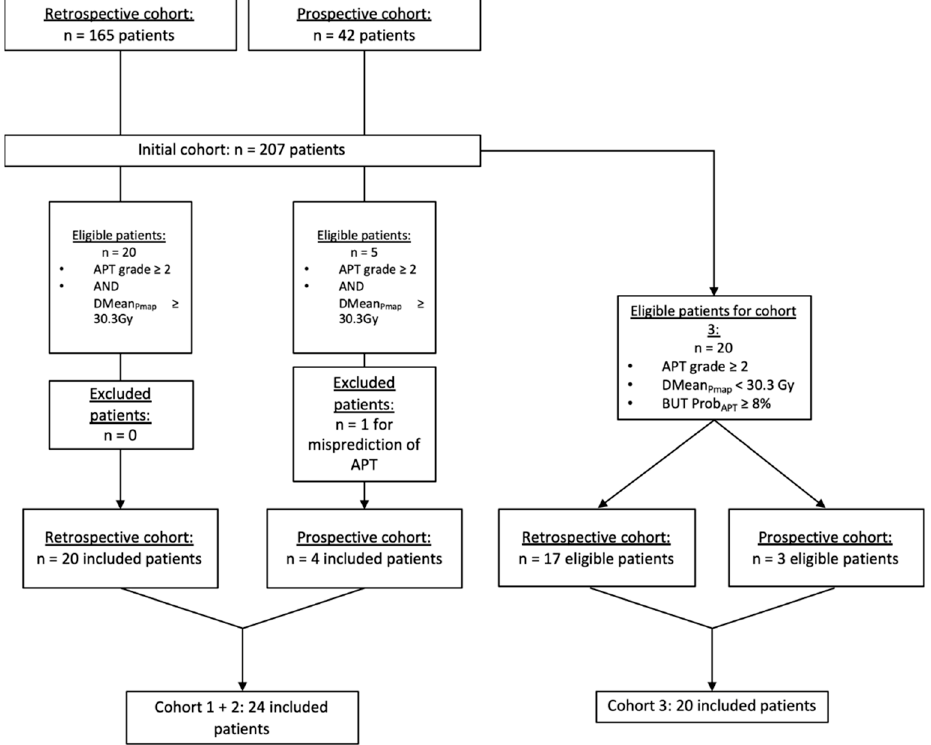
Figure 1. Flowchart of the patients’ selection. Abbreviations: APT: Acute Pulmonary Toxicity, DMean Pmap : mean dose received by the Pmap ‐ region, Prob APT : the probability of an APT ≥ grade 2 based on the Pmap ‐ prediction model.